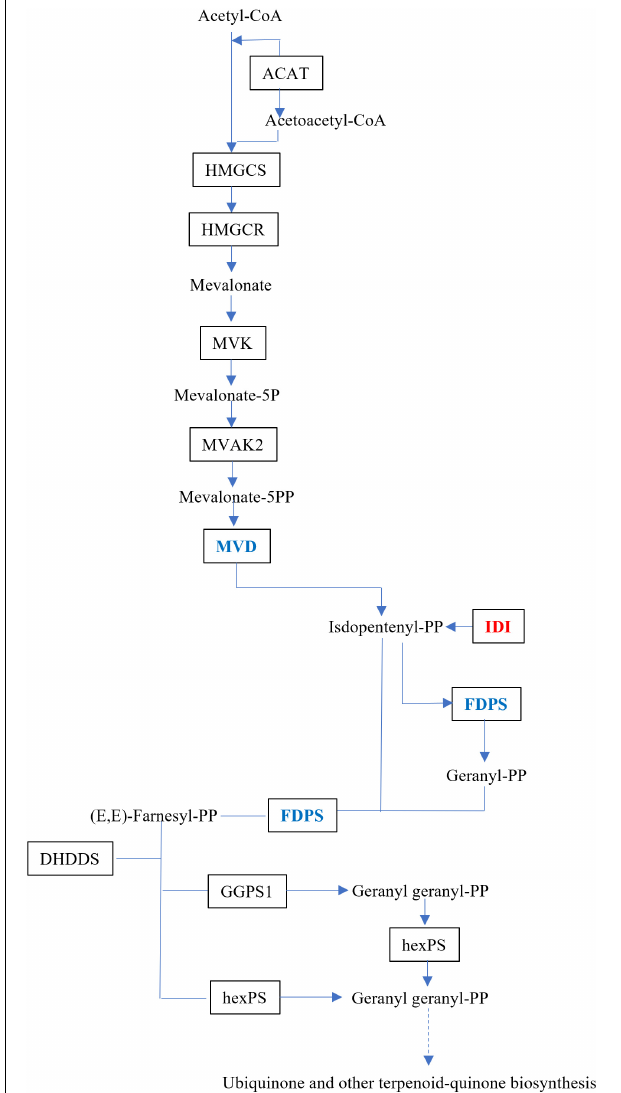
FIGURE 5 | Schematic illustration of MVA biosynthetic pathways in MD33. Abbreviations, as quoted in the figure, are as follows. MVD, diphosphomevalonate decarboxylase; IDI, isopentenyl-diphosphate Delta-isomerase. Expression changes of the genes associated with MVA pathway in the MeJA treatment group and Control. Red indicates up-regulated genes and green indicates down-regulated